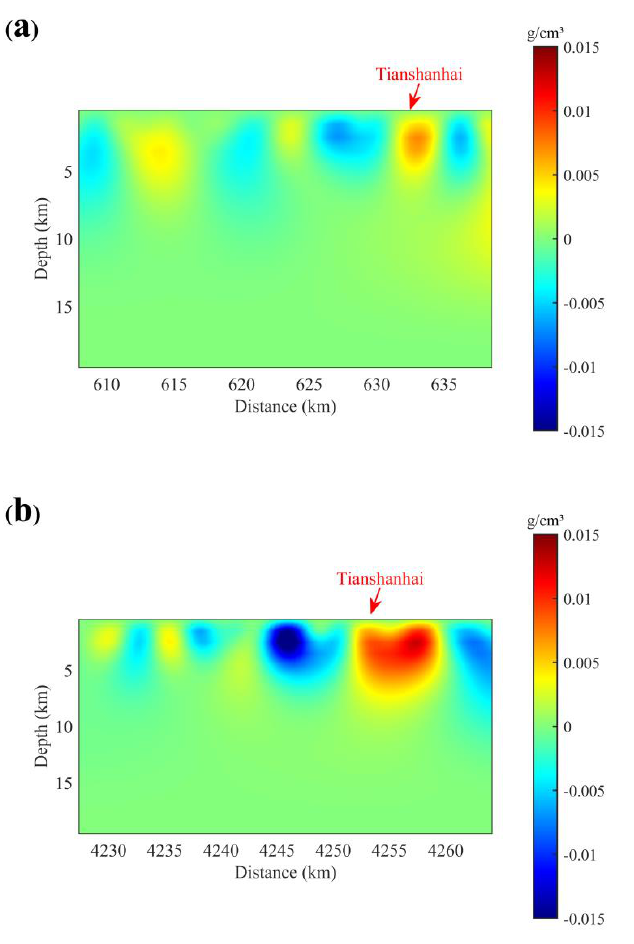
Figure 7. Vertical sections crossing the Tianshanhai area in ( a ) north-south direction; ( b ) east-west direction.